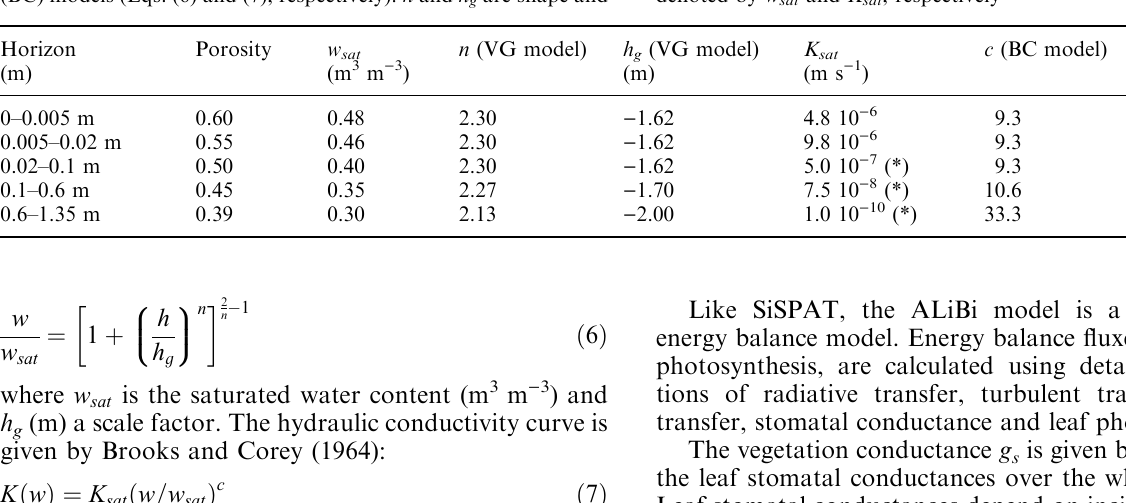
Table 3. Soil parameters for the five SiSPAT’s horizons, either measured or calibrated (*) using the SiSPAT model. They include the coe(cid:129)cients of the van Genuchten (VG) and Brooks and Correy (BC) models (Eqs. (6) and (7), respectively): n and h